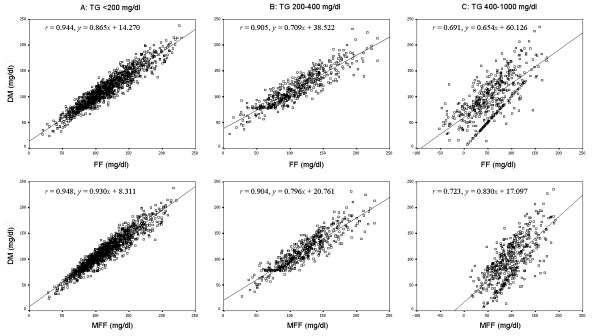
Correlations for LDL-C in subjects with different TG values. The LDL-C values were significantly correlated between the MFF and DM (P < 0.001)